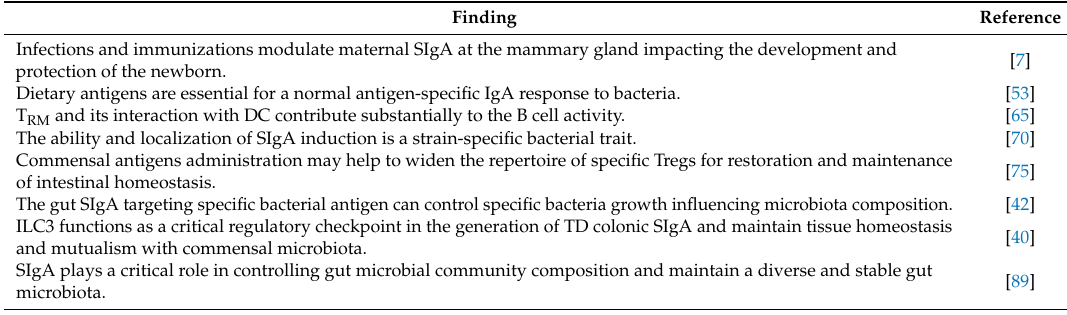
Table 2. Summary of recent findings on SIgA in mucosal